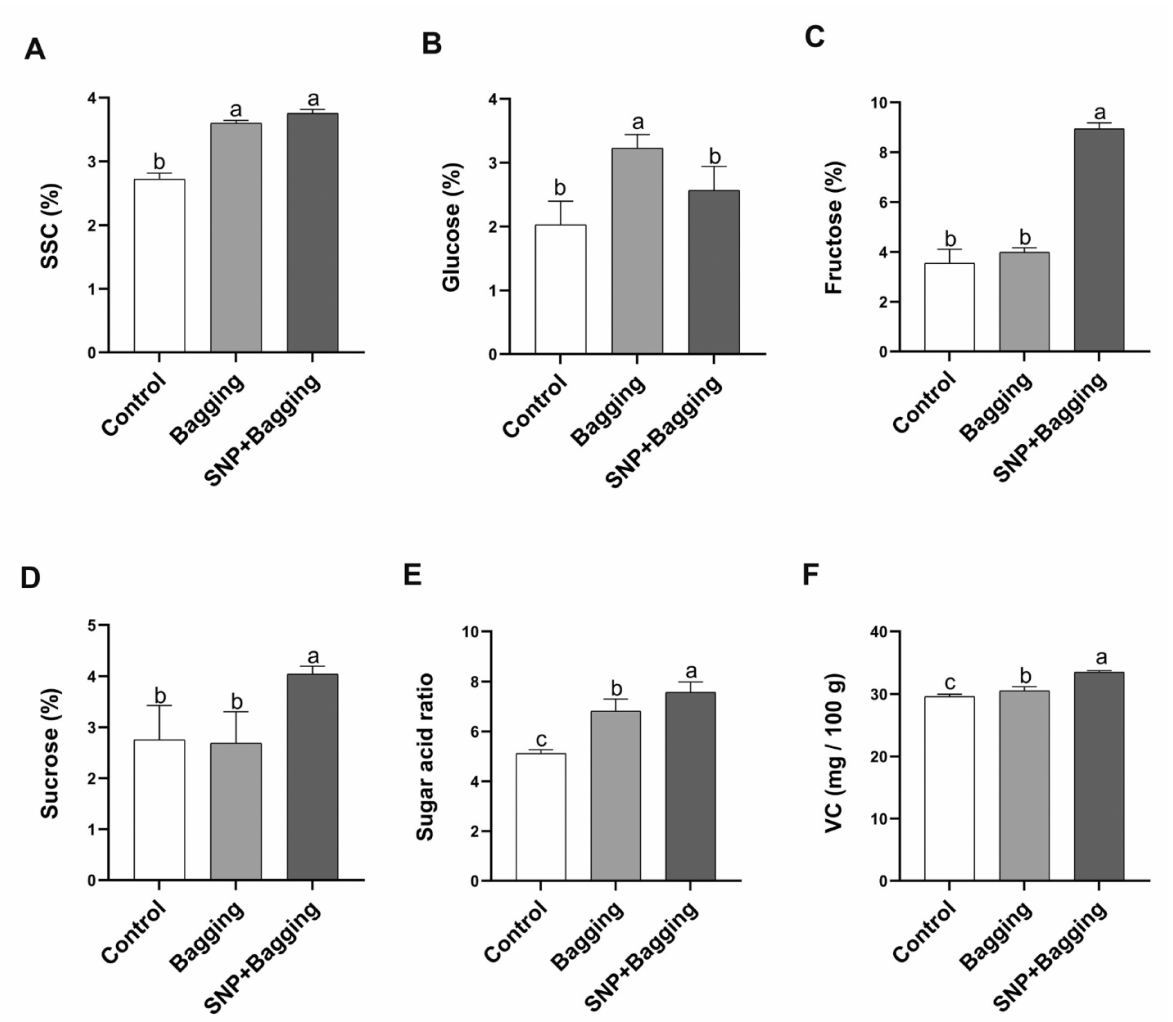
Figure 3. Effects of different treatments on the soluble sugar content (SSC; A ), glucose content ( B ), fructose content ( C ), sucrose content ( D ), sugar–acid ratio ( E ), and vitamin C (VC) content ( F ) of blood orange fruit pulp. Error bars show standard deviations ( n = 3). Different lowercase letters indicate significant differences at 0.05 ( p < 0.05)